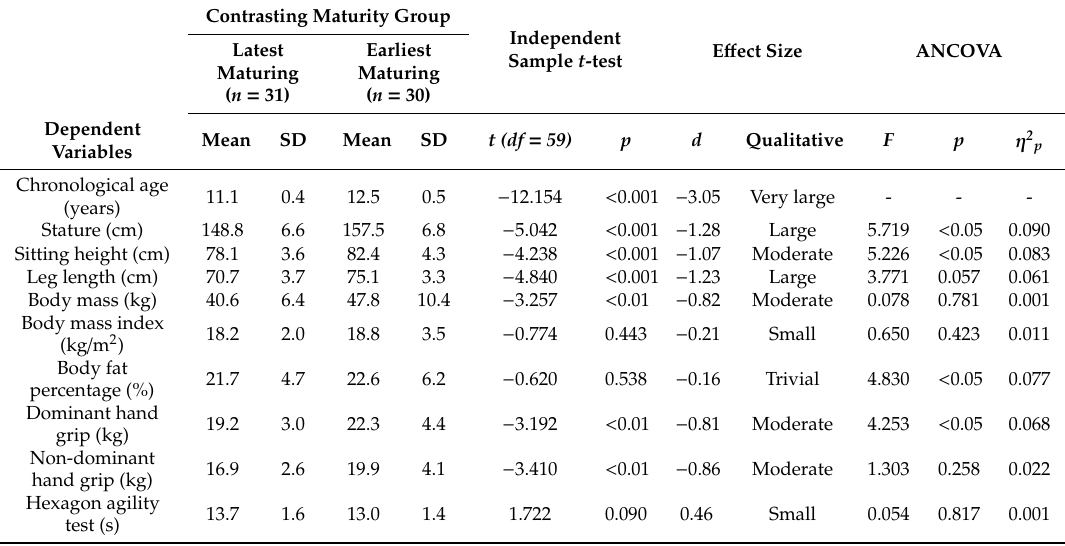
Table 3. Descriptive statistics (mean and standard deviation), results from independent sample t-test, e ff ect size given by Cohen’s d and ANCOVA (controlling for chronological age) of the anthropometric profile and physical fitness comparison between the two contrasting maturity